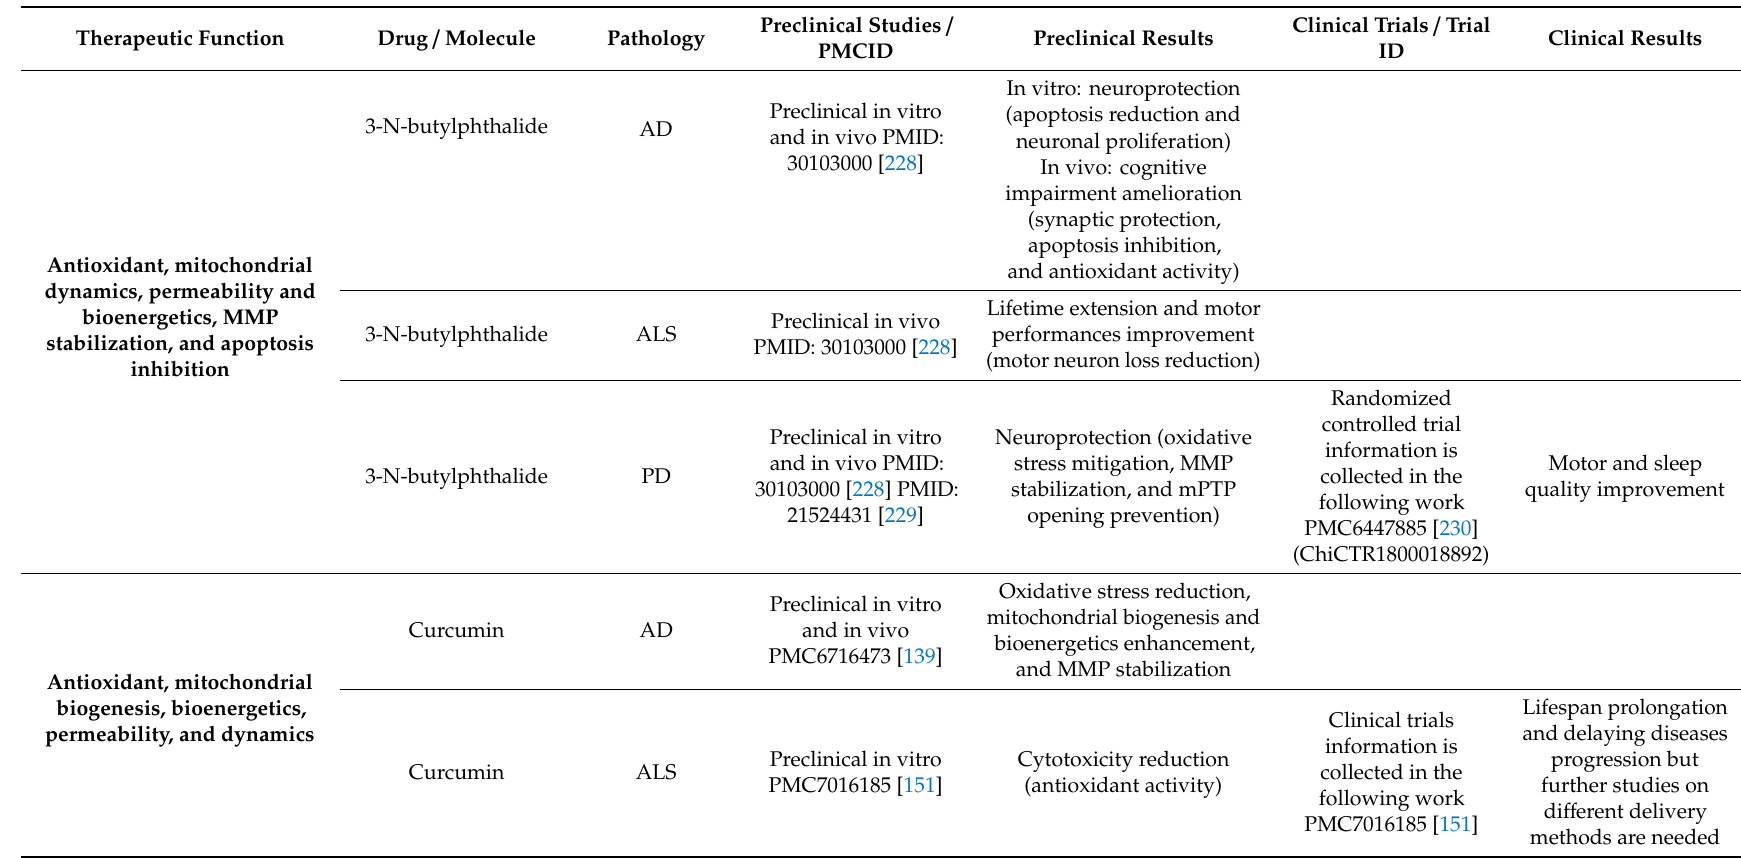
Table 5. Compounds targeting simultaneously di ff erent mitochondrial dysfunctions. The table lists the molecules that have been tested in preclinical studies or in clinical trials and that regulate several mitochondrial processes impaired in neurodegenerative diseases. For clinical trial ID we referred to https: //